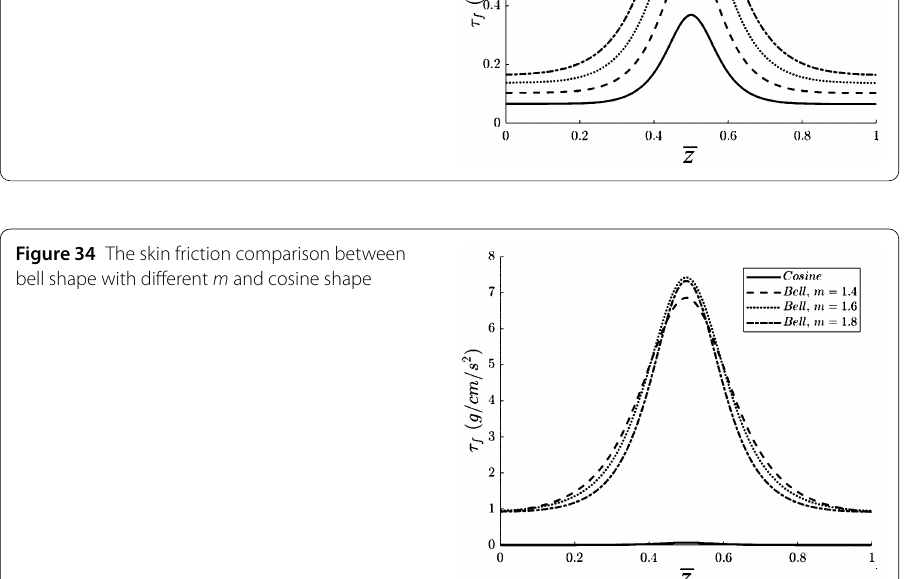
Figure 33 Variation of skin friction with axial distance for different stenosis lengths in bell shape stenosis